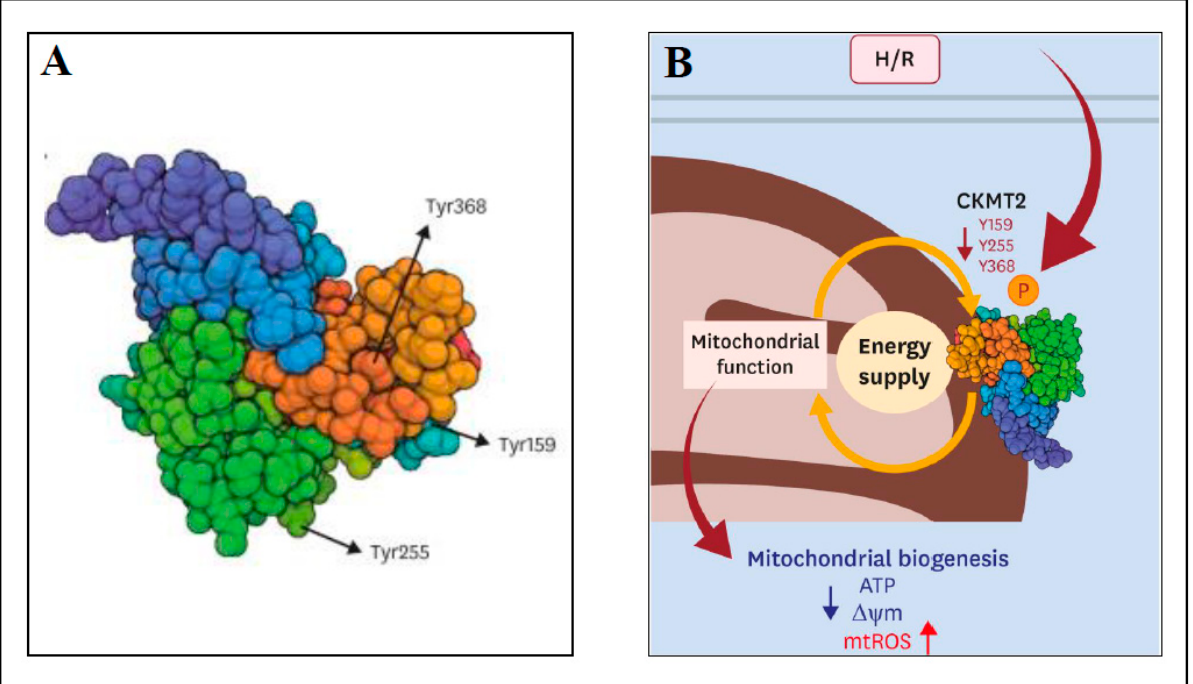
Figure 1. Cardioprotection against H/R injury by tyrosine phosphorylation of human CKMT2. ( A ) The structure of human CKMT2 with three phosphorylated sites of tyrosine (Y159, Y255 and Y368); ( B ) A scheme indicating the tyrosine residues affected during H/R, which led to modulation of CKMT2 activity and mitochondrial function. H/R—hypoxia/reoxygenation, ATP—adenosine triphosphate, ∆ψ m—mitochondrial membrane potential, mtROS—mitochondrial reactive oxygen species. More details can be found in the text. This figure was adapted from ref. [111].